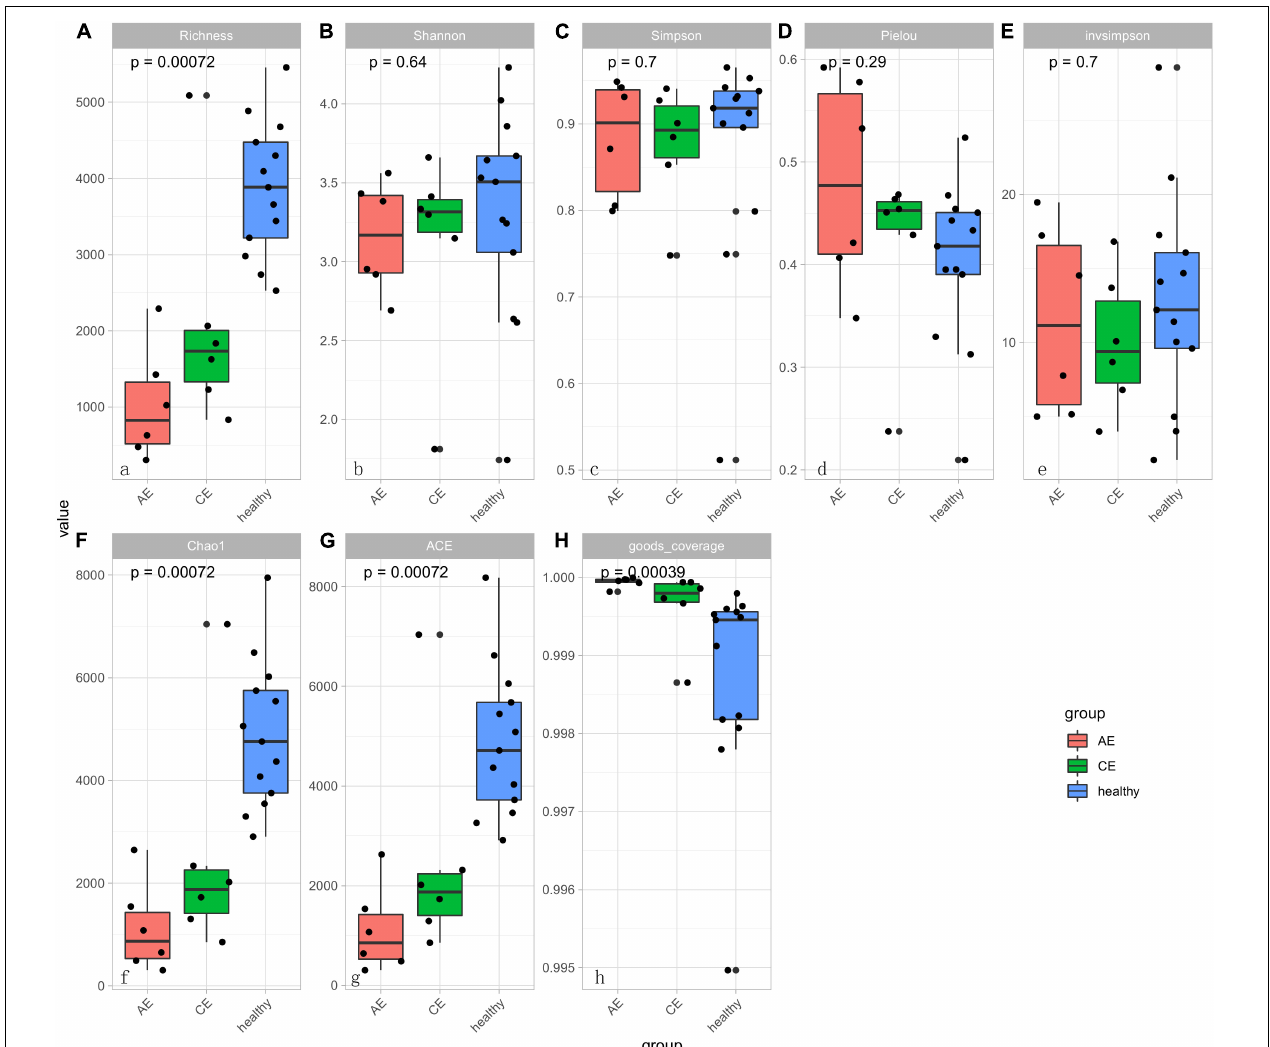
FIGURE 5 | The diversity boxplot shows α -diversity in patients with alveolar echinococcosis (AE), patients with cystic echinococcosis (CE), and healthy people. Alpha-diversity estimations are similar for control, AE and CE groups. Results are presented as box and whiskers’ plots per group (AE, CE, and control) and per metric: (A) Richness; (B) Shannon index; (C) Simpson index; (D) Pielou; (E) Inv Simpson; (F) Chao1 index; (G) ACE index; (H) Good-coverage index. There were significant different in panels (A,G,F,H) ( P < 0.001). That means the sample is rich in species. There was no significant differences of sample diversity between AE, CE, and healthy